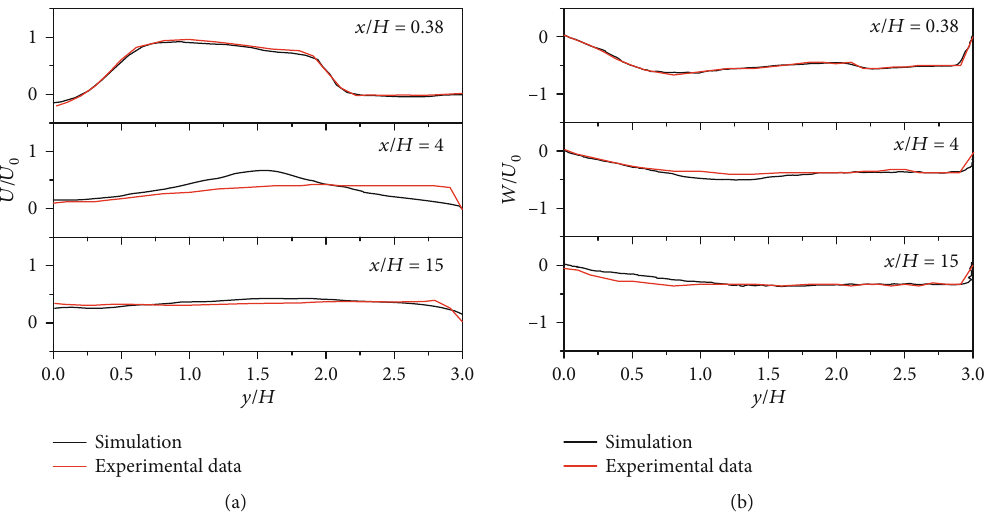
Figure 4: Normalized axial velocity (a) and tangential velocity (b) for swirling fl ow.